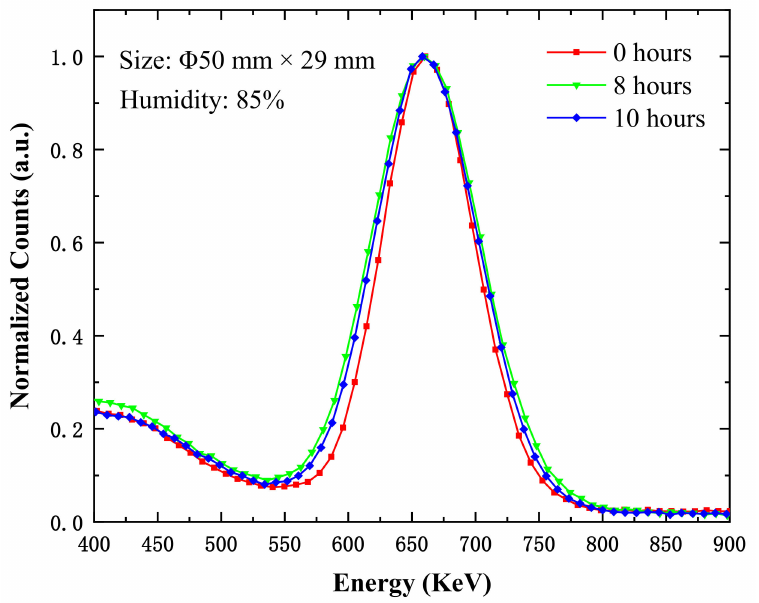
Figure 7. The energy spectra of the CsI(Na) crystal (size: Φ 50 mm × 29 mm) with different exposure times at 85% relative humidity under 137 Cs-662 keV γ ray